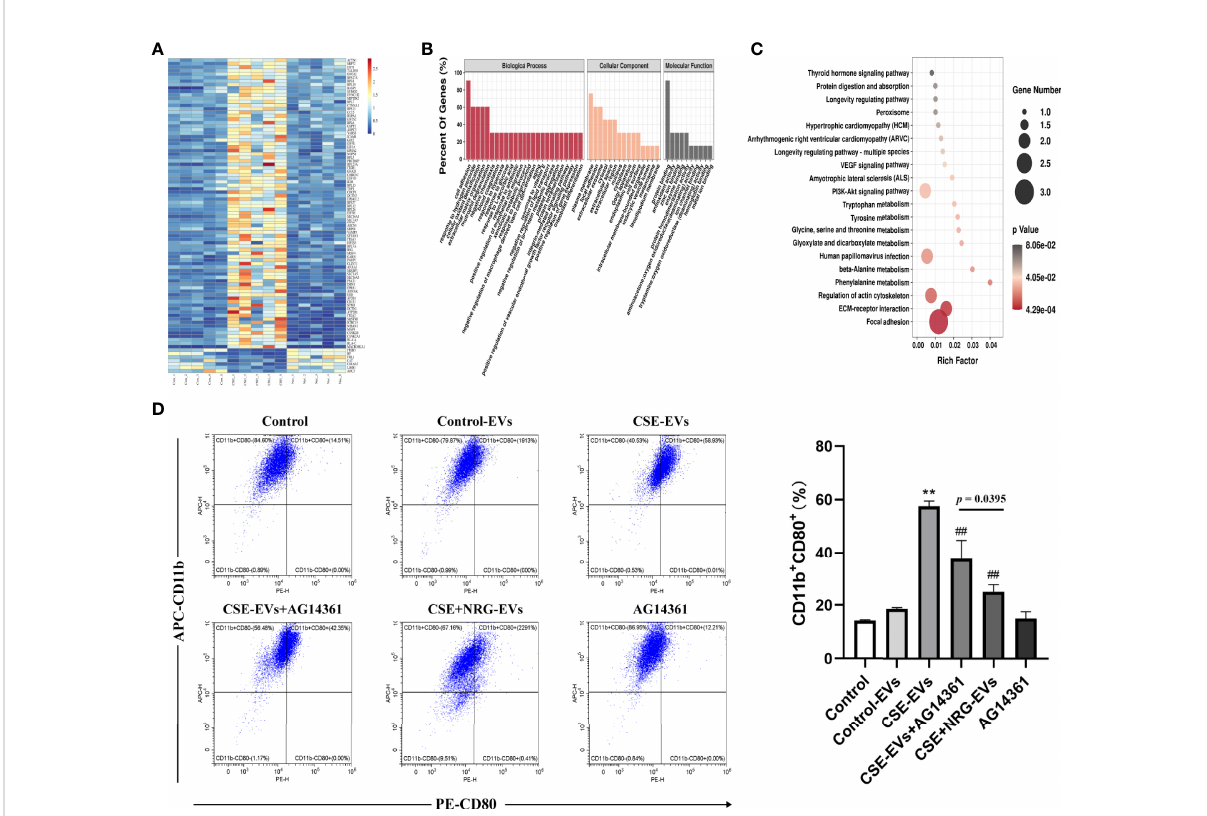
FIGURE 7 Naringenin decreased BEAS-2B-derived EVs poly ADP-ribose polymerase (PARP)1 expression thereby suppressing M1 macrophage polarization probably. (A) The heat map for 91 EVs proteins which were signi fi cantly reversely expressed by the treatment of naringenin. Aggregation of the same color blocks indicated proteomics reproducibility (n = 5). (B) GO analysis for biological process, cellular component, and molecular function terms were performed on 91 reversed EVs proteins. (C) KEGG pathway enrichment analysis for the 91 EVs protein targets. The size of the dot indicates the number of target genes in the pathway, and the color of the dot re fl ects the different p -value. (D) Representative fl ow cytometry data on CD11b + CD80 + THP-1 macrophages treated by EVs or AG14361 (PARP1 inhibitor) (n = 3). ** p <0.01 vs . Control-EVs group. ## p <0.01 vs . CSE-EVs